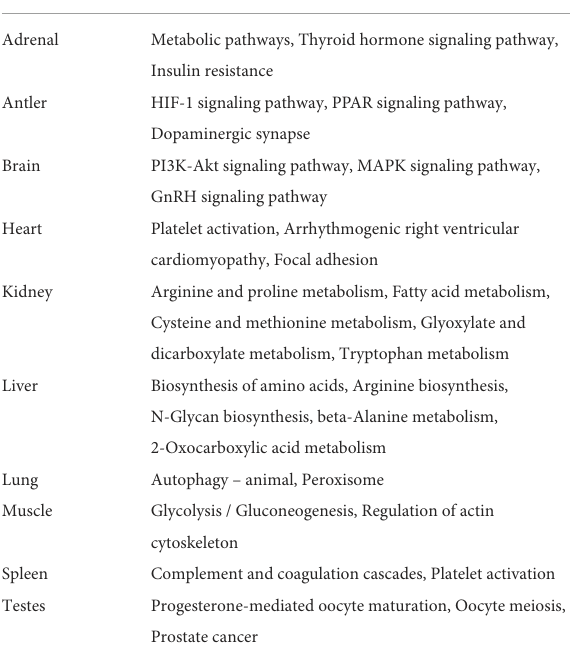
TABLE 3 Number of DE miRNAs in two different developmental